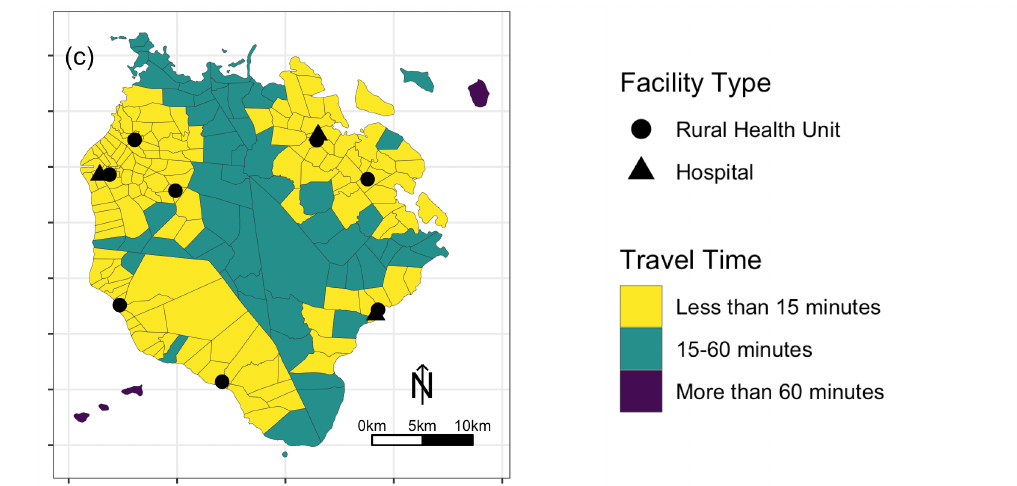
Figure 6. Map of travel-time interval to the nearest healthcare facility of different transportation modes: ( a ) tricycle; ( b ) jeepney; and ( c ) private car.